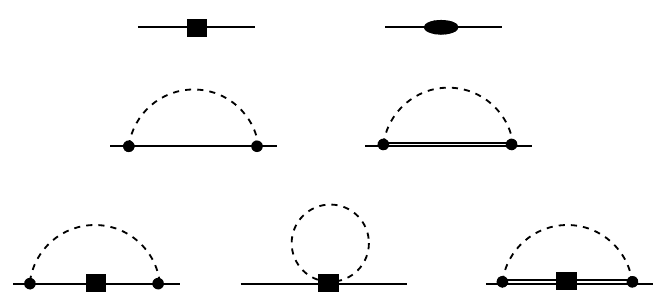
Figure 1 . Feynman diagrams contributing to the masses up to fourth order. The contact terms at second and fourth order, the leading loop and the next-to-leading loop corrections are given in the (cid:12)rst, second and third row, respectively. Solid, dashed, and solid double lines refer to octet baryons, Goldstone bosons, and decuplet states, respectively. Vertices denoted by a (cid:12)lled dot/square/ellipse refer to insertions from the (cid:12)rst/second/fourth order chiral Lagrangian, respectively. Diagrams contributing via wave function renormalization only are not